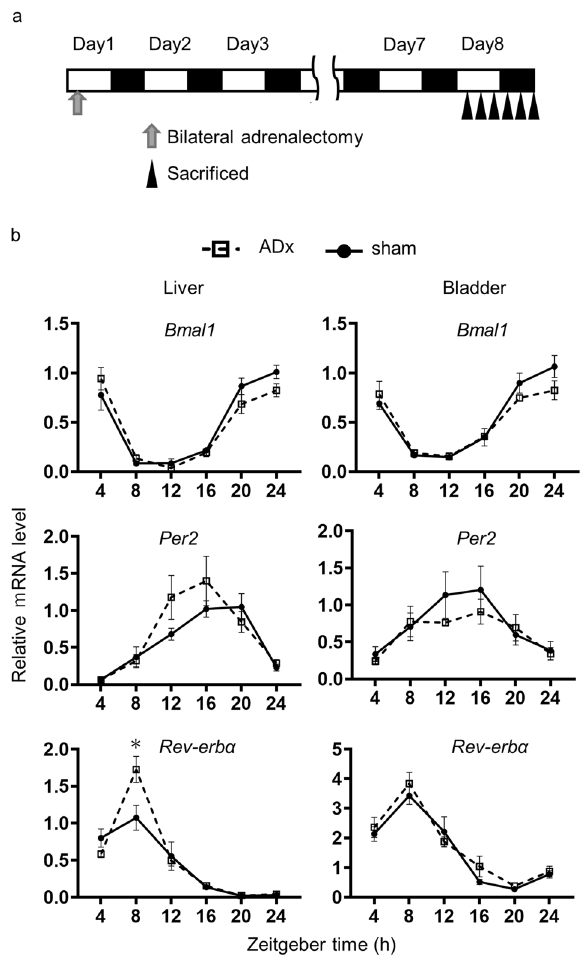
Fig. 4 Effect of bilateral adrenalectomy. a A schematic diagram of the experiment that bilateral adrenalectomy (ADx) performed on Day 1 and sacri fi ce death on Day 8. b Relative mRNA accumulation of Bmal1 , Per2, and Rev-erb α in the liver and bladder from sham (solid line) and ADx (dash line). Each data series represents the mean ± SEM and 5 mice per time point. Differences were determined by two-way ANOVA and Sidak ’ s multiple comparisons test. * p < 0.01 v.s.